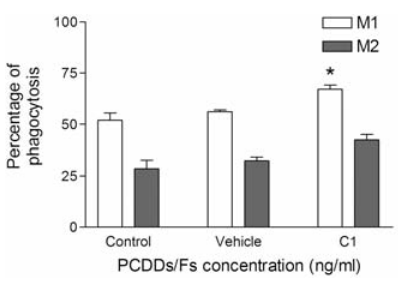
Figure 3. Phagocytic response of cœlomo- cytes following 3 h of preincubation with polychlorinated dibenzo -p- dioxins/diben- zofurans (PCDDs/Fs) and 18 h with beads (M1: cells engulfed one bead and more, M2: cells engulfed three beads and more). Data are presented as mean ± SD (n=6) and asterisk indicates significant difference (P<0.05) from